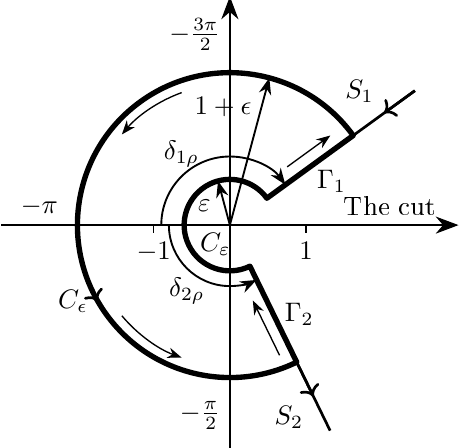
Figure 2. The auxiliary contour of integration Γ